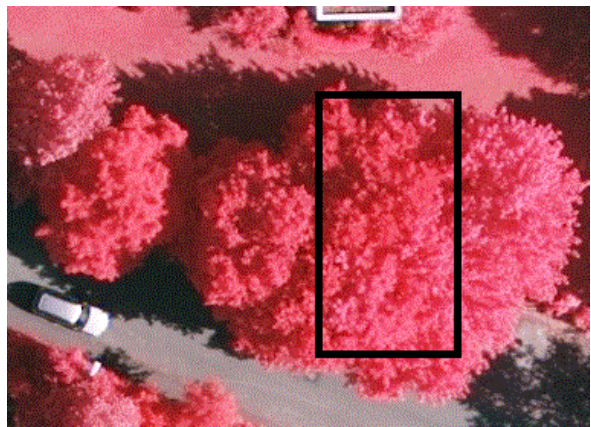
Figure 5. A multi trunk trees.